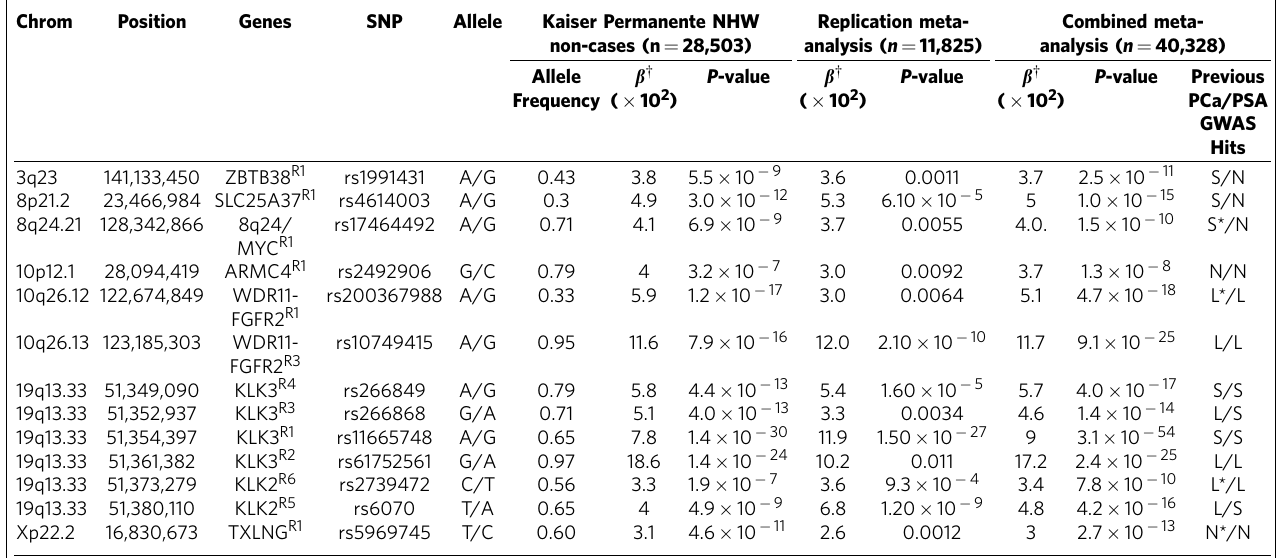
(Table 2). Full details of conditional models given in Supplementary Tables 1–3. *, ** Associated with PCa in our study adjusting for PSA: * P o 0.00125, **0.00125 o P o 0.05. R1 Conditionalround1,conditioningon:rs6662386,rs4951018,rs9306895,rs13395387,rs2556375,rs35350834,rs56935123,rs10023685,rs37004,rs74786629,rs6920449,rs10486567,rs13272392,